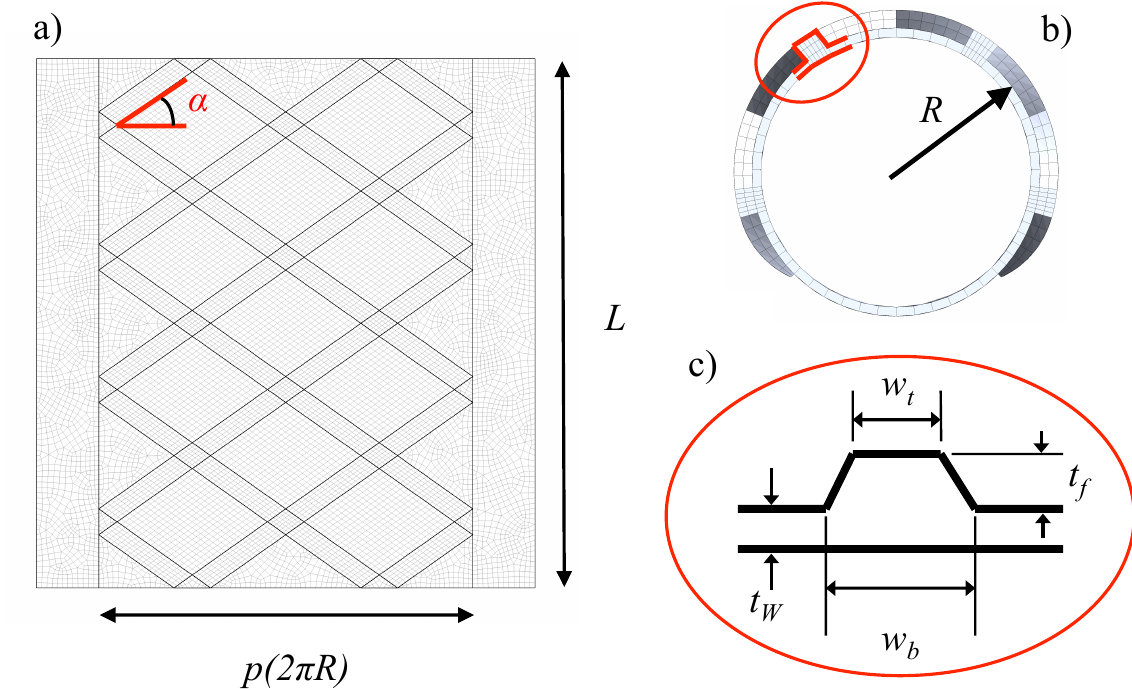
Figure 2. Parametrization of the tracheobronchial stent prototype: ( a ) unwrapped geometry, ( b ) top section of the tubular configuration and ( c ) detail of the stent